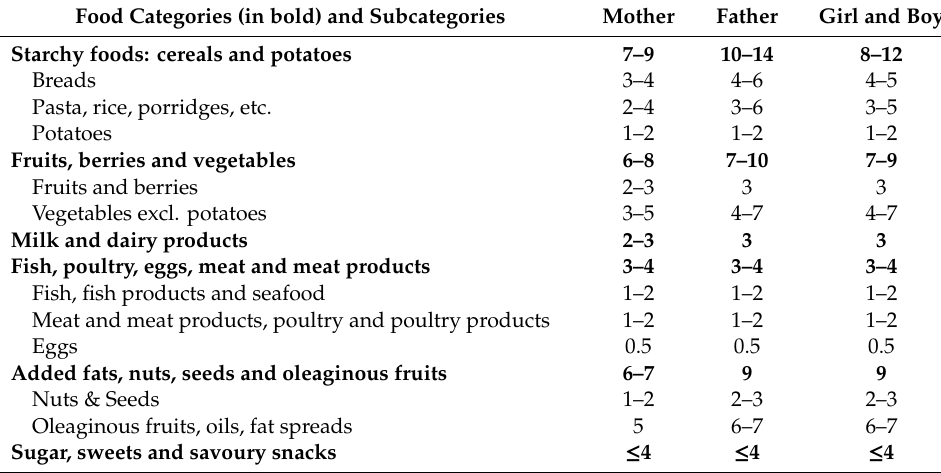
Table 2. Number of daily portions per food group as recommended in national dietary guidelines applied to the healthy food basket (HFB) and the nutritionally adequate and healthy food basket (NHFB) according to estimated energy requirements